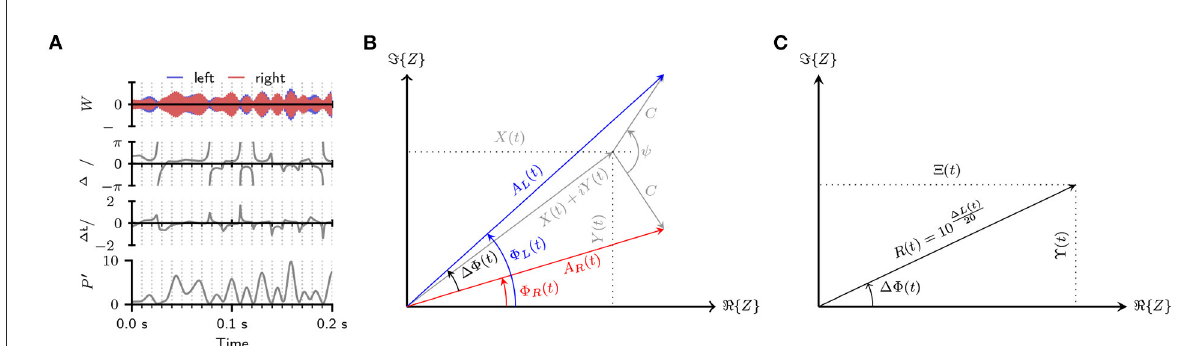
FIGURE1 (A) Visualization of the random fluctuations in IPD 18 ( t ) and ILD 1 L ( t ) and P ′ ( t ) due to mixing an antiphasic 500 Hz tone with a 500Hz wide band of diotic noise (SNR = 10dB). (B) Signal model used to derive the PDFs for an N 0 S ψ stimulus. The graphic shows the Complex-plane − A L ( t )e i 8 L ( t ) (blue), and Z R ( t ) A R ( t )e i 8 R ( t ) (red). The left-ear-baseband is representation of the basebands of the left and right ear signal: Z L ( t ) = = iY ( t ). The right-ear-signal is constructed by constructed by adding a “tone”-vector with length C and angle ψ / 2 to the noise baseband X ( t ) + + adding a “tone”-vector with an angle of ψ / 2 to the same baseband. The instantaneous IPD 18 ( t ) of the N 0 S ψ signal equal the difference − i ϒ ( t ) which is gained by dividing the 4 ( t ) between 8 R and 8 L . (C) Complex-plane representation of the interaural-baseband Z 1 ( t ) = + left-ears-baseband by the right-ears-baseband. The absolute value of the baseband equals the interaural amplitude ratio R while the phase equals the interaural phase difference 18